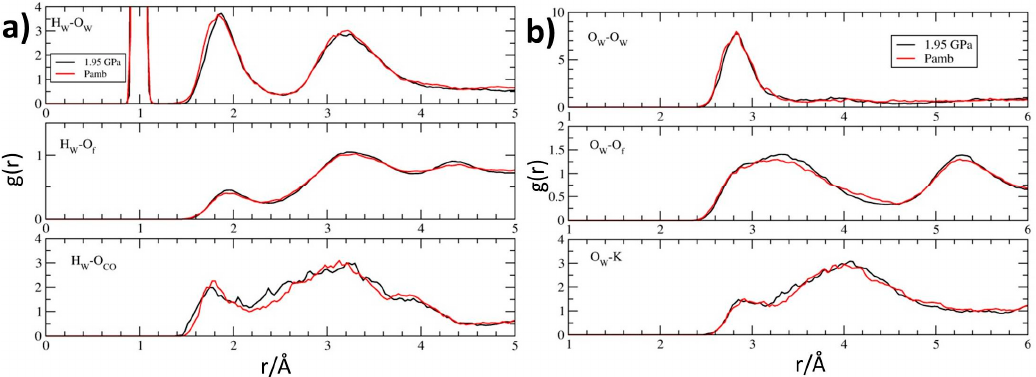
Figure 9. Pair distribution functions g(r) from the room-temperature FPMD simulations relative to P amb (red) and P = 1.95 GPa (black), calculated for: ( a ) the water hydrogens H w with water oxygens O w (top), framework oxygens O f (middle), carbonyl oxygens O FL (bottom); ( b ) the water oxygens O w with water oxygens (top), framework oxygens O f (middle) and potassium cations (bottom). Table 3. Calculated average diameters of 12 MR channel in Å from room-temperature FPMD simulations at different compression for the hydrated ZL/1.5FL system.